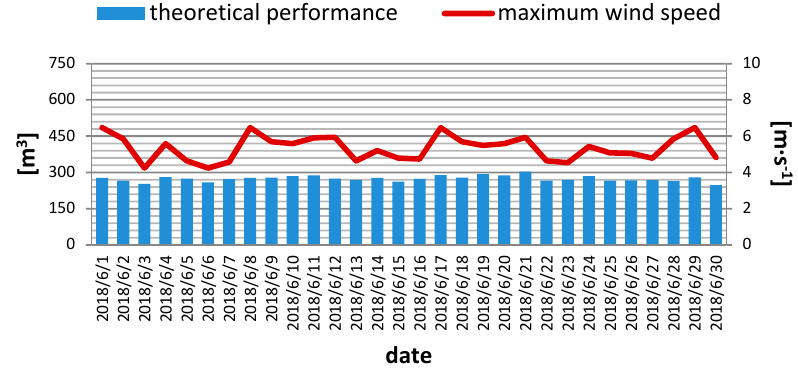
Figure 7. Efficiency of the pulverization unit of the aerator in June.